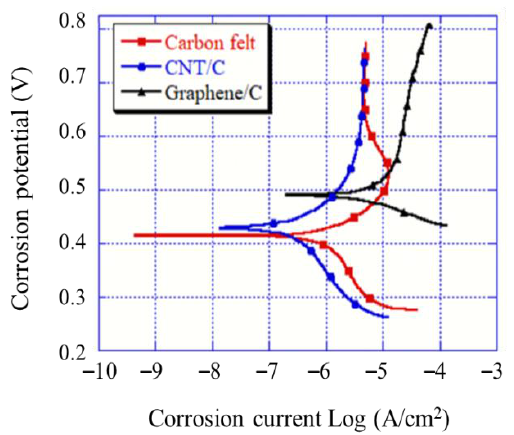
ff erent modifications of carbon Figure 5. T afel curves for different modifications of carbon felt. Figure 5. Tafel curves for di Figure 5. T afel curves for different modifications of carbon felt.